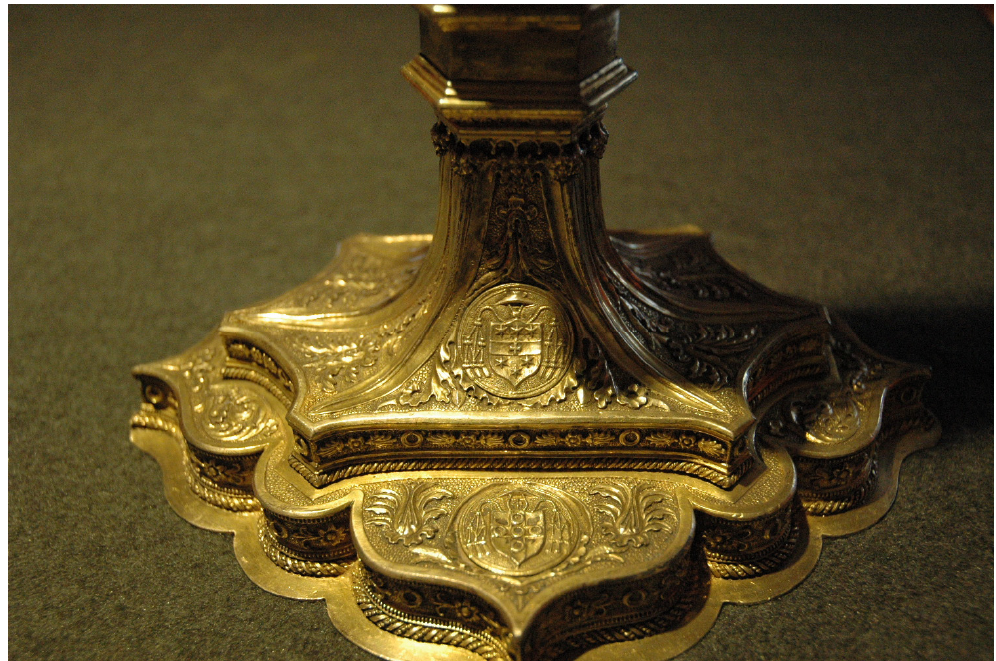
Figure 3. Detail from Figure 1. Cardinal Piccolomini’s and Casini’s coat of arms on the rear of the Ostensory (photo: author).